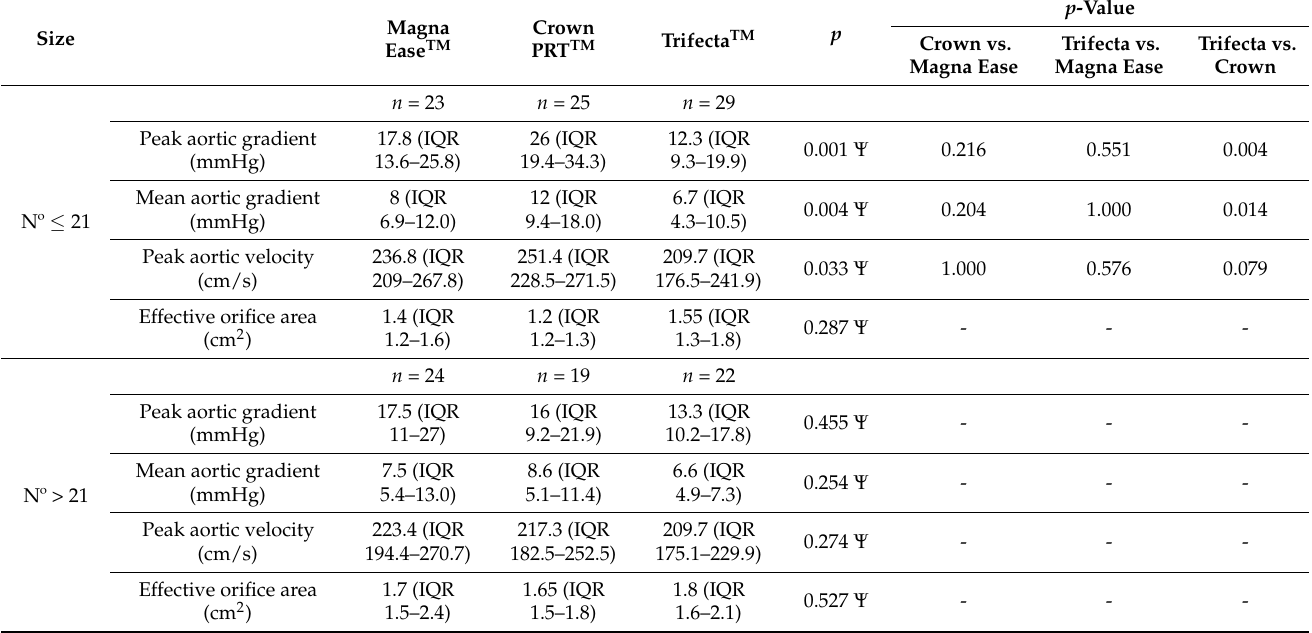
Table 3. Echocardiographic findings stratified by prosthetic size at 12 months after surgery.